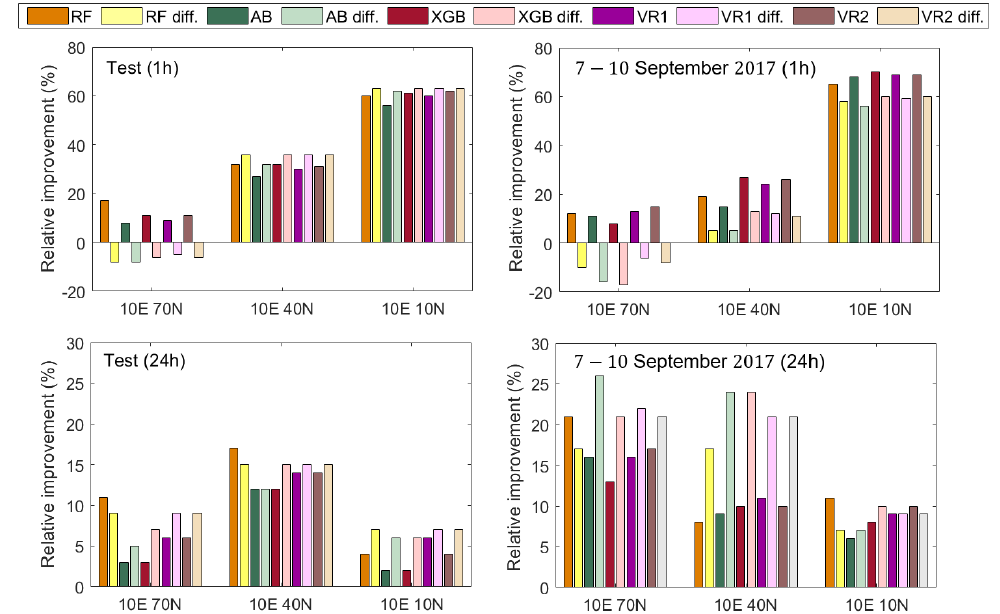
Figure 13. Relative RMSE change with respect to the persistence (naive) forecast. Top : 1 h forecast, bottom : 24 h forecast. Left : test data (2017), right geomagnetic storm (7–10 September 2017). Models trained of differenced data are marked with